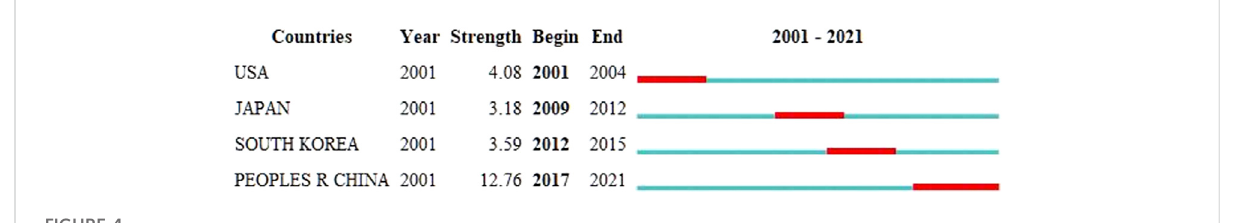
FIGURE 4 Top four countries/regions with the strongest citation bursts. A variable experiencing large changes in a short period of time indicates a strong burst of citations, and the red bar indicates the duration of the burst.